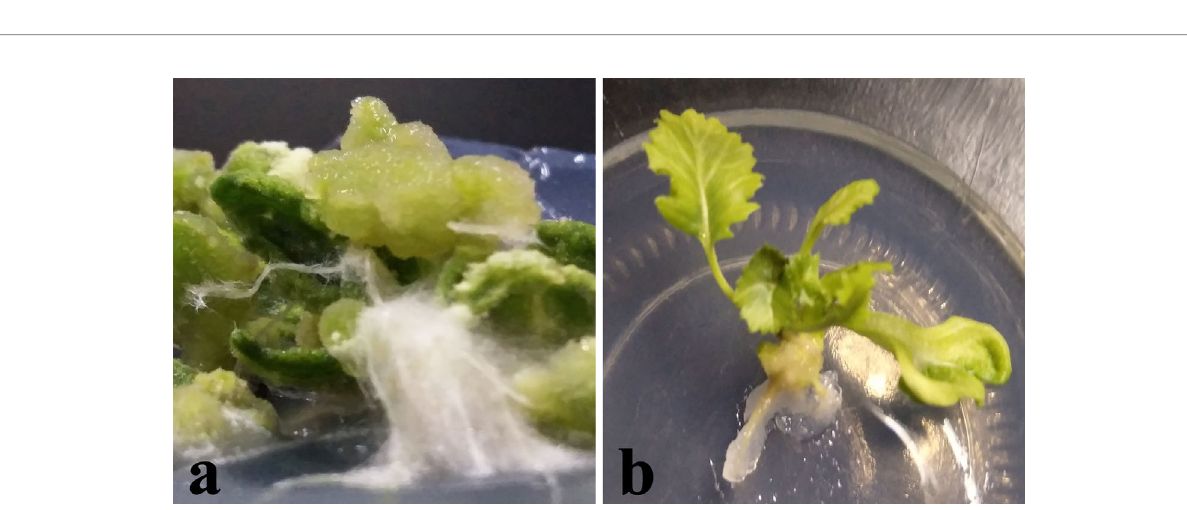
FIGURE 11 | Plant callus system for leaf segments of B. napus cultivar Tianyou2238 (cold sensitive). To characterize callus growth in response to cold stress, calluses were grown in 200-ml fl asks containing 50 ml of liquid MS medium. After four weeks incubation, the formed calluses (a) and plants (b) were divided into groups: one was maintained at 25°C as the non-cold control and the other was subjected to cold stress at